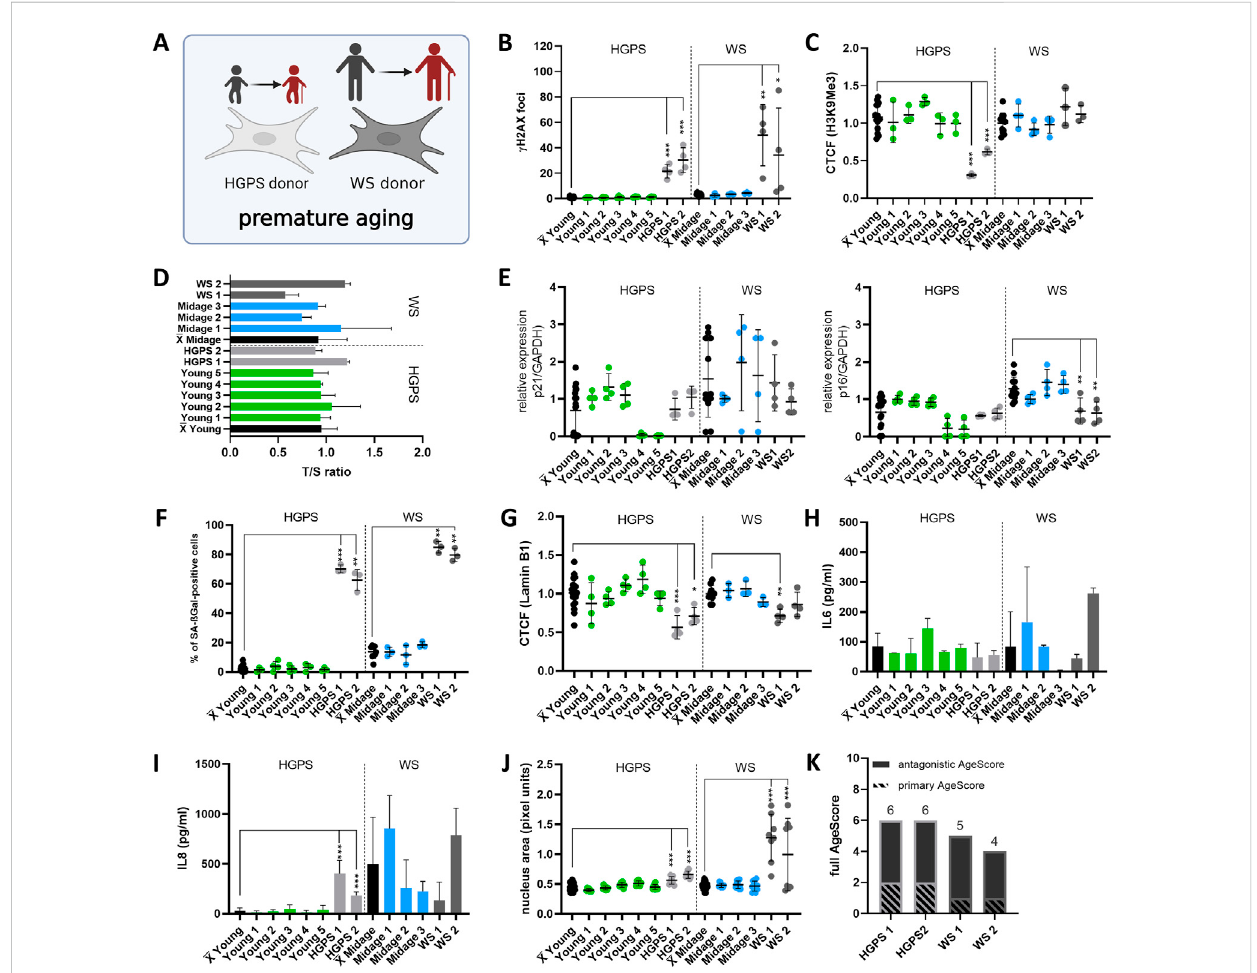
FIGURE 6 Application of the AgeScore on Progeria syndromes. (A) Cell Model for validation of proposed AgeScore in fi broblasts of donors with Progeria Syndrome in comparison to young/mid-age donors. (B) Amount of γ H2A.X foci per cell examined by IF stainings to investigate DSBs. There were an increasein γ H2A.Xfociinallcellsoftheprematureagingsyndromes.[ n =3 – 4(eachntested > 15cells),mean±SEM,* p < 0,05,** p < 0.001,***p < 0,0001, one-wayANOVA] (C) CTCFofH3K9Me3inhuman fi broblastsofProgeriapatients.TherewasadecreaseinH3K9Me3expressionindonor fi broblasts of HGPS patients (HGPS 1 and HGPS 2). [ n = 3 – 4 (each n tested > 15 cells), mean ± SEM, * p < 0,05, ** p < 0.001, ***p < 0.0001 , one-way ANOVA] (D) Telomere length were measured by MM-qPCR in comparison to a standard of healthy mixed aged individuals. There were no change in telomere length of human fi broblasts of progeria syndrome patients in comparison to age-matched controls. [ n = 3, mean ± SEM, * p < 0.05, ** p < 0.001, ***p < 0.0001 , one-wayANOVA] (E) RNAexpressionlevelsmeasuredbyqRT-PCRofp21andp16.ActivationofcellcyclearrestweredetectedinWSbyupregulatedRNA expression levels of p16. [ n = 3-4, mean ± SEM * p < 0.05, ** p < 0.001, ***p < 0.0001 , one-way ANOVA] (F) Quanti fi cation of SA- β GAL positive cells by X-Gal staining. Donor fi broblasts from premature aging syndromes showed asigni fi cant rise ofSA- β GAL positive cells. [ n = 3 – 4 (each n tested > 15